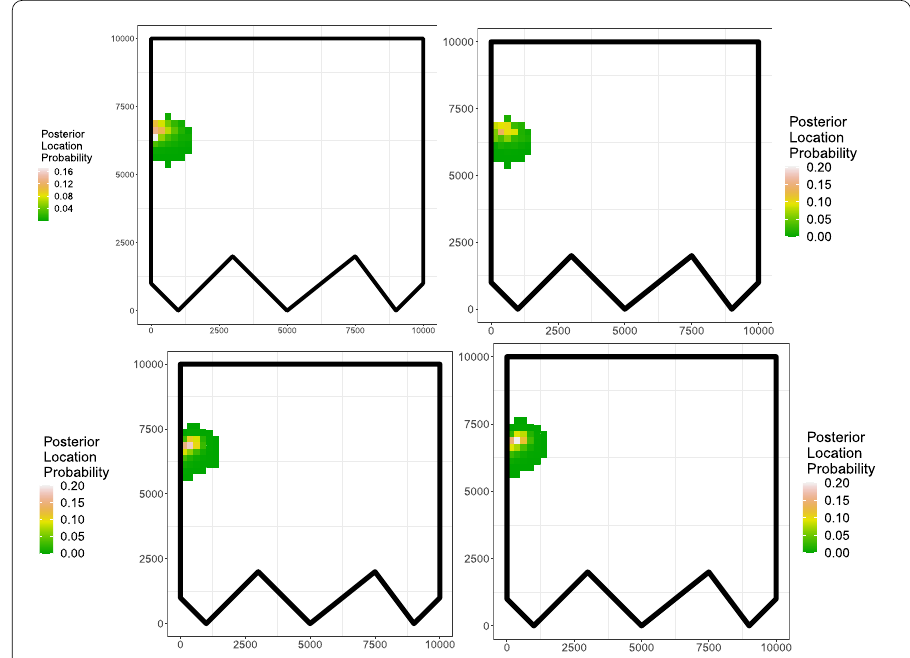
Figure 4 Posterior location probabilities. Posterior location probabilities at time t = 0 for a given device under emission models RSS with uniform prior (top left), RSS with network prior (top right), SDM with uniform prior (bottom left), and SDM with network prior (bottom